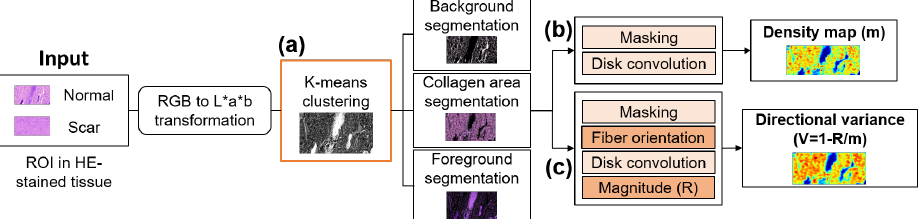
Figure 4. Block diagram of collagen density extractor using ( a ) K-Means clustering, ( b ) collagen density extractor, and ( c ) directional variance of